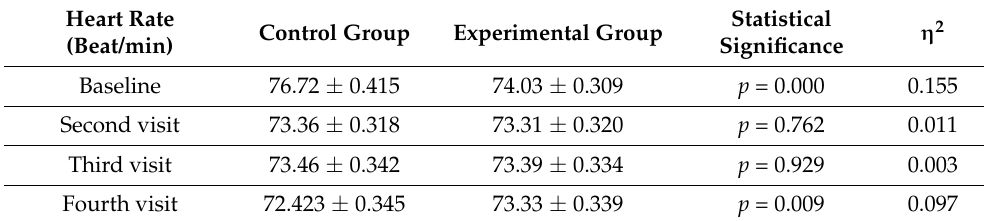
Table 4. Values of heart rate in the study population. Results are presented as mean ± standard means of errors (X ± SEM) in control and experimental groups. Statistical difference was confirmed by Mann–Whitney U test. An eta-squared ( η 2 ) value reflects the strength or magnitude related to a main or interaction